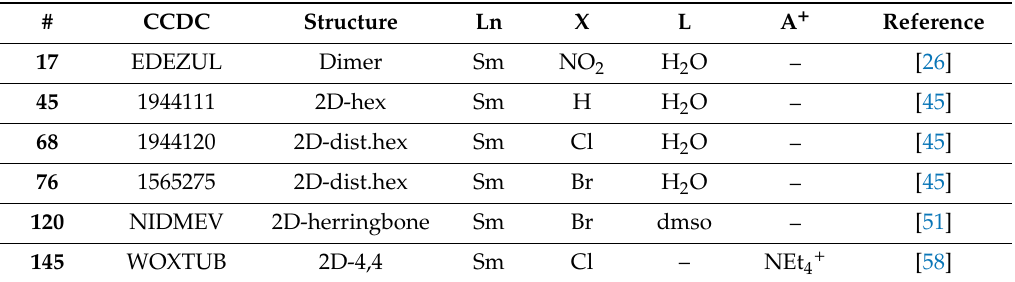
Table 18. Structurally characterized Sm(III) compounds with anilato ligands.